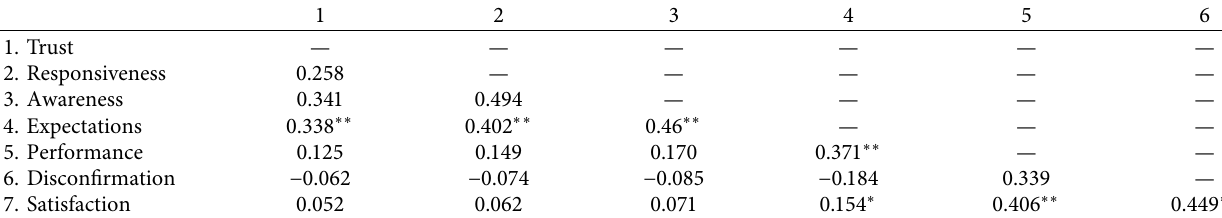
Table 2: Correlation matrix of